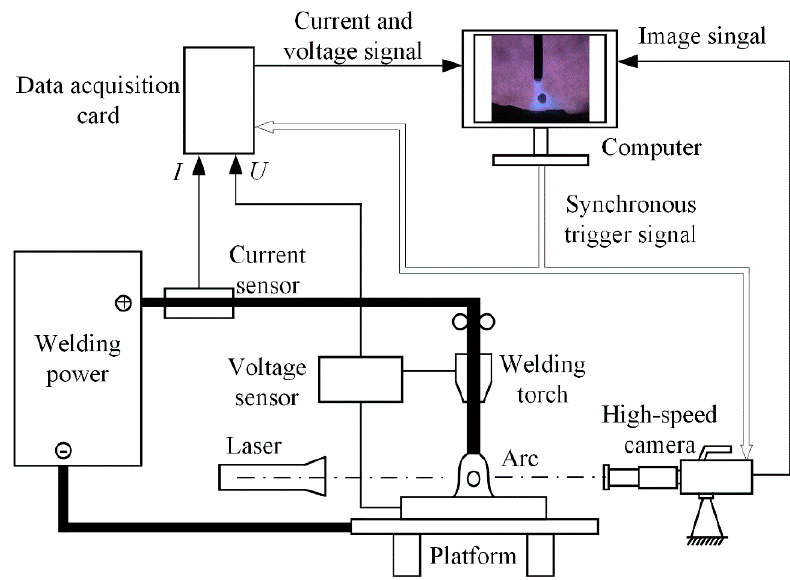
Figure 1. Schematic diagram of high-speed photography, current, and voltage signal synchronous acquisition system.